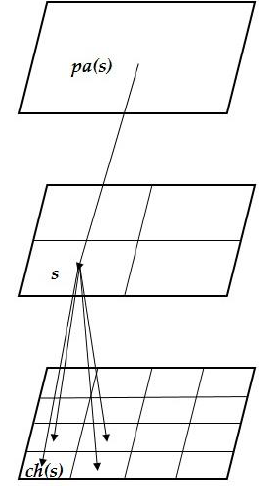
Figure 2. Multi-resolution Kalman filter (MKF) data structure [25].